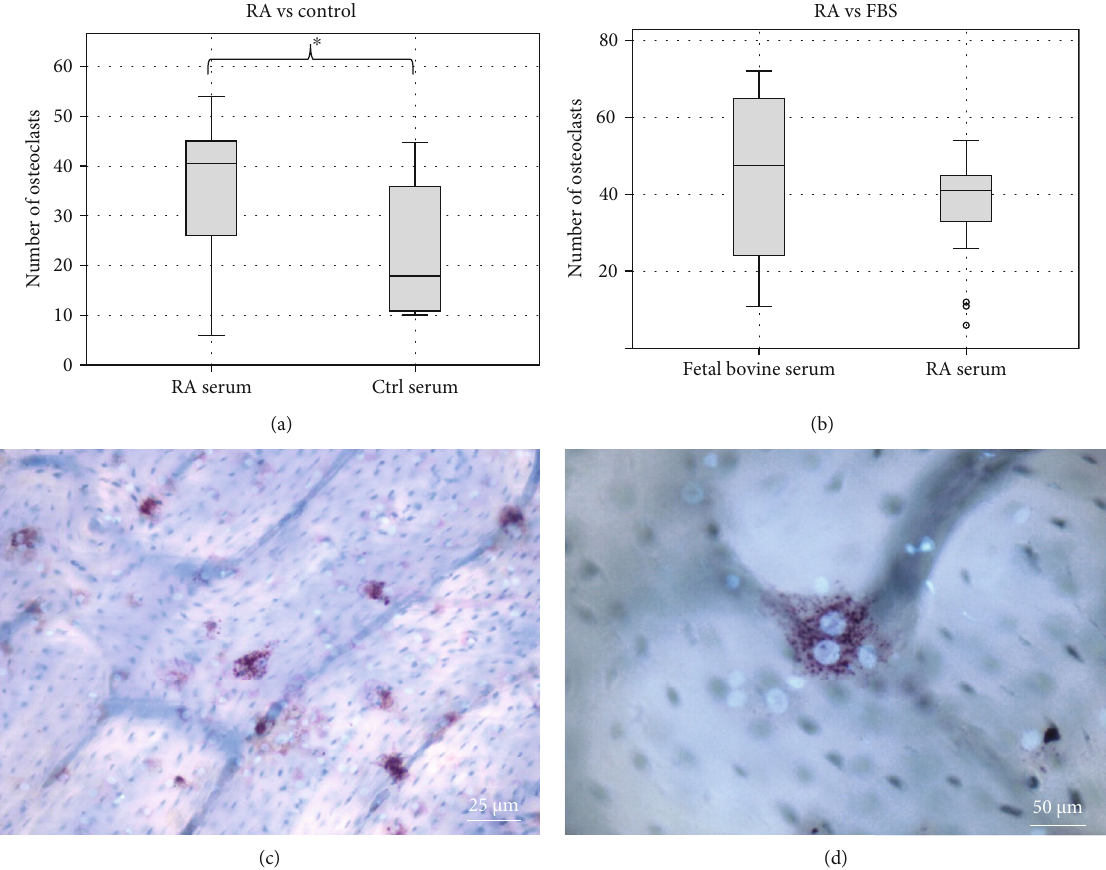
Figure 3: Osteoclast numbers in cultures with RA and healthy serum. Panel (a) shows the mean number of osteoclasts on bone slices in cell cultures with treatment-naïve RA patient serum ( n = 15 ) and healthy control serum ( n = 13 ). RA serum increased the number of osteoclasts signi fi cantly compared to healthy serum. Only multinucleated TRAcP positive cells were counted as osteoclasts. (b) Number of osteoclasts in cultures with FBS, which was used as a positive control. (c) 10x magni fi cation and (d) 20x magni fi cation from RA serum sample. No morphological di ff erences were seen between the cells cultured with RA serum or healthy control serum. Red color indicates TRAcP and blue Hoechst stain marks the